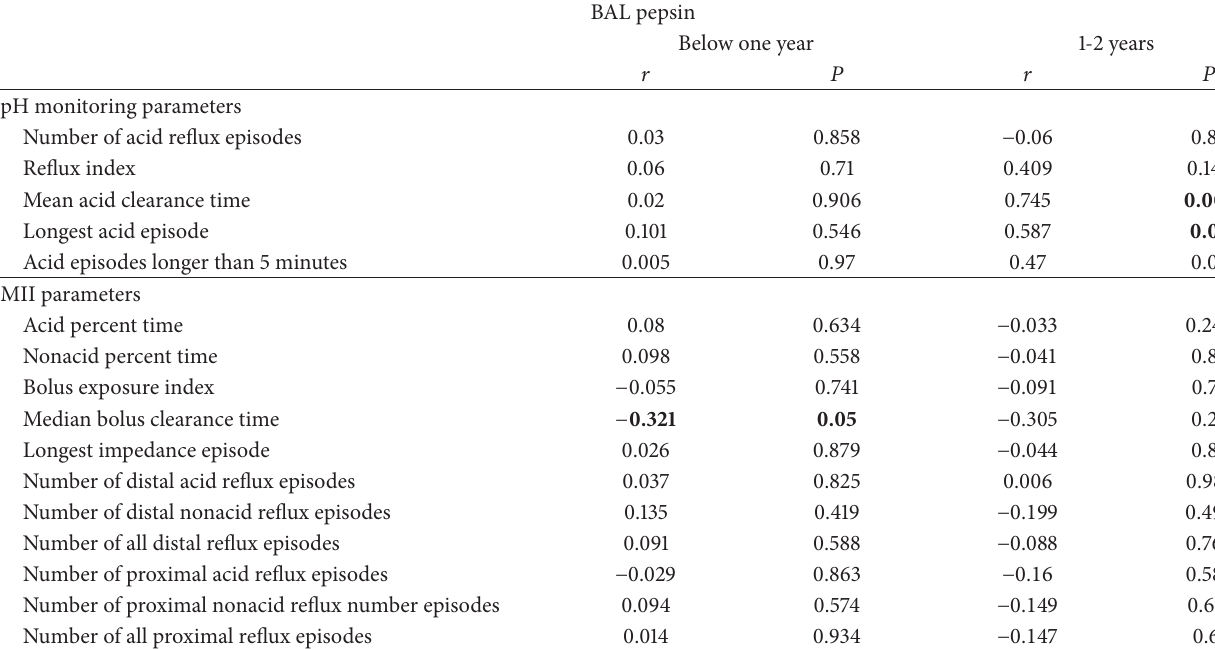
Table 3: Bronchoalveolar fluid pepsin correlation with MII-pH monitoring